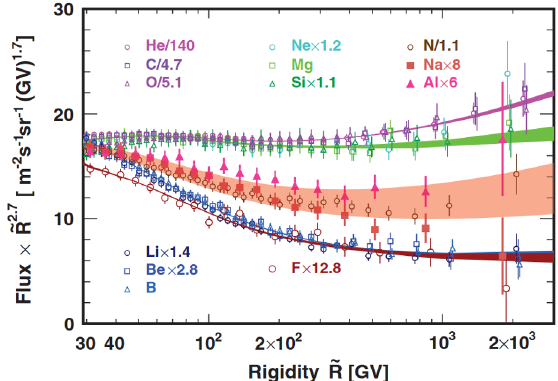
Figure 11. Nuclei spectra measured by the AMS-02 collabora- tion [24].